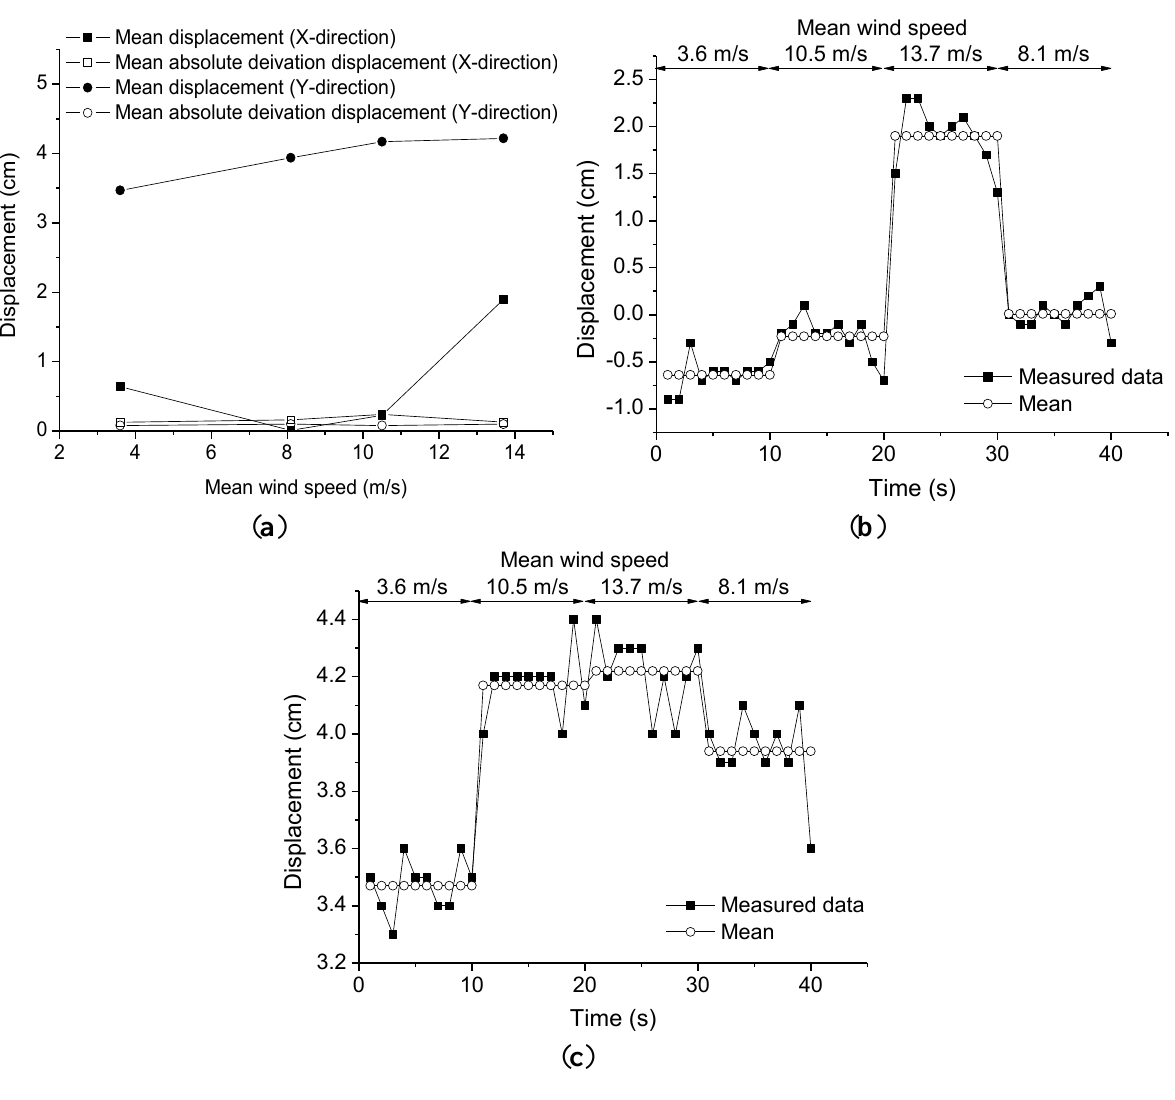
Table 5. Variation of displacements for different mean wind